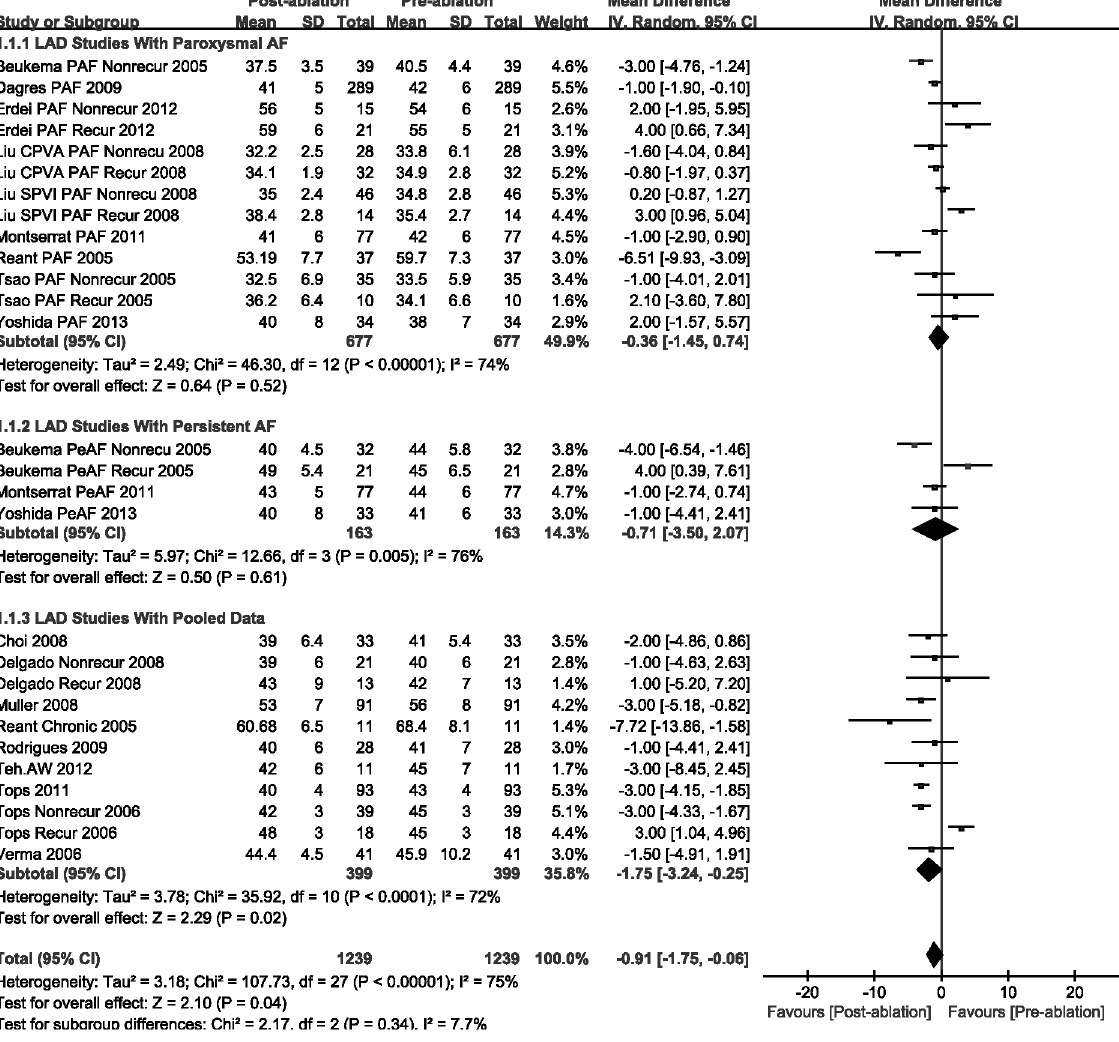
Fig 2. A forest plot of comparison: changes in left atrial diameter (LAD) pre-ablation and